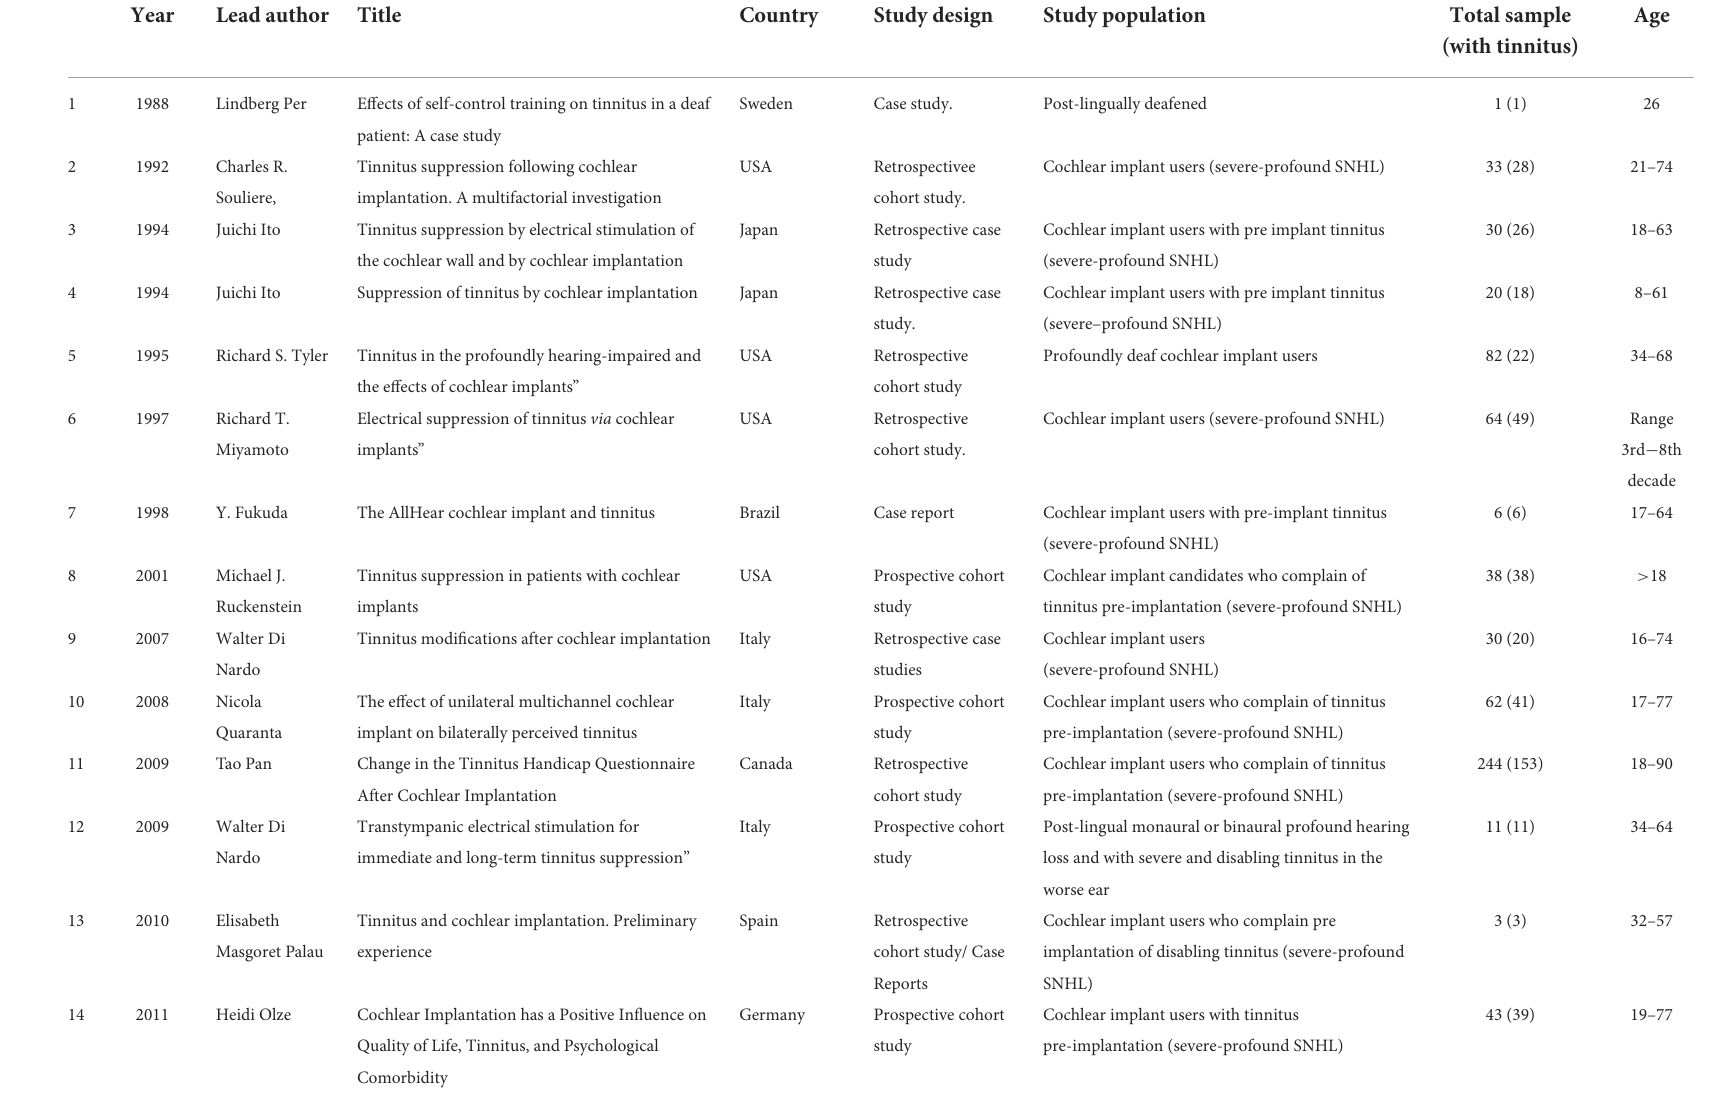
TABLE 3 Characteristics of included studies (year, author(s), title, country, study design, study population, size of sample with tinnitus, and